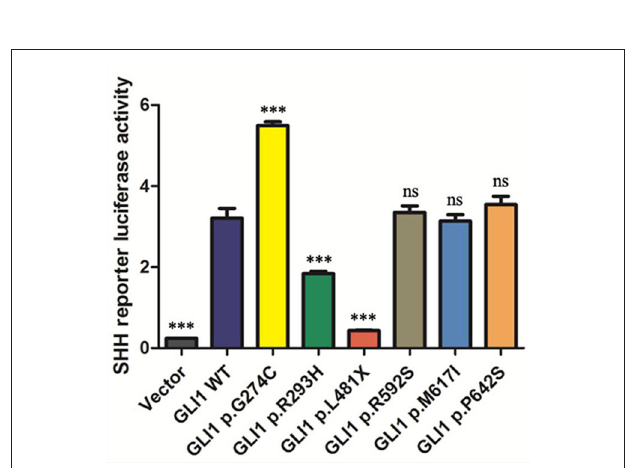
FIGURE 2 | The statistical analyses of luciferase relative activity for HEK293T cells co-transfected with expressing plasmids as indicated and Sonic hedgehog (SHH) signaling pathway reporter plasmids. Activation of SHH signaling pathway pGMGLI-Lu firefly luciferase reporter by human GLI1 wild-type or mutants 24h post-transfection in HEK 293T cells. Constitutively expressed Renilla Reniformis Luciferase served as an internal control (n ≥ 3, * P < 0.05, ** P < 0.01, *** P < 0.001, ns, not significant, compared with wild-type